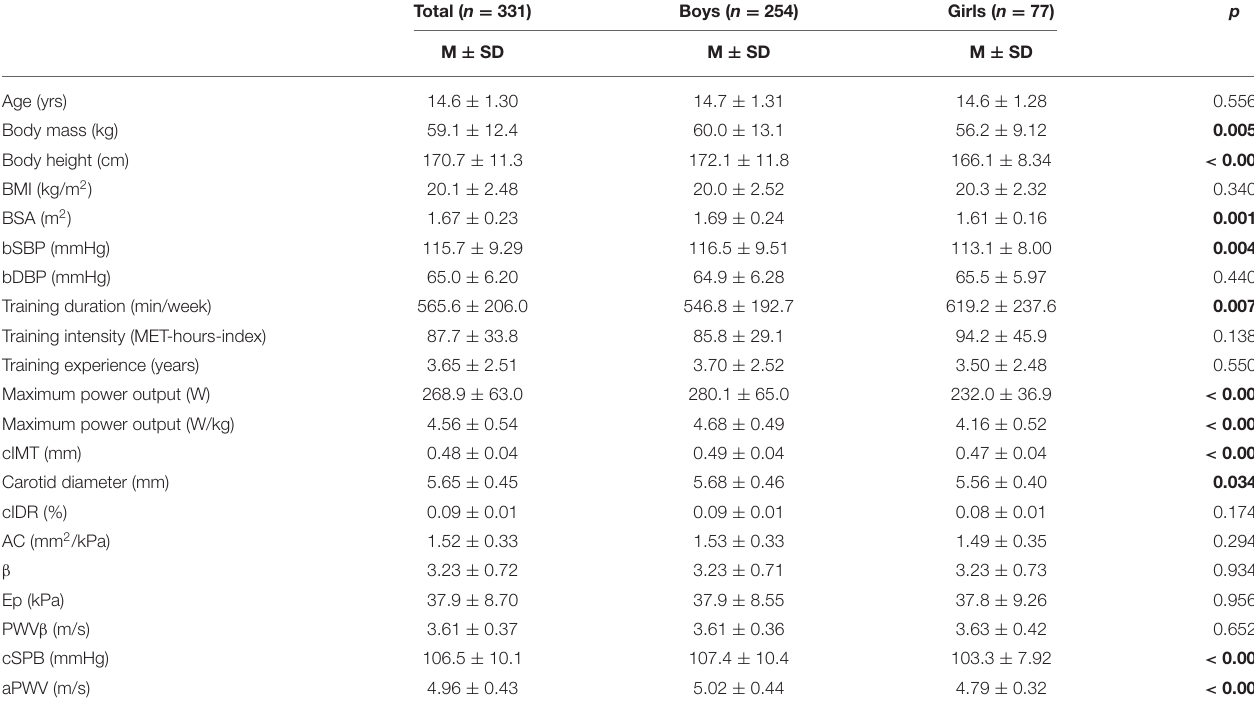
TABLE 1 | Study characteristics.